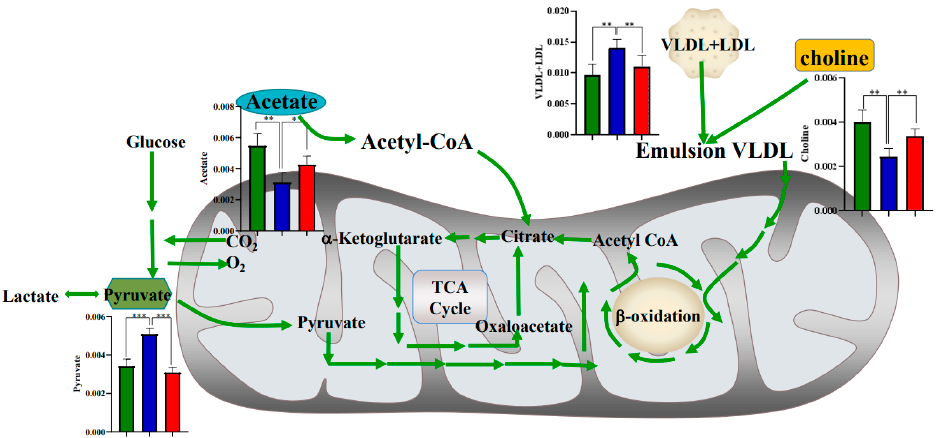
Figure 7. Metabolic regulatory network induced by SAP deficiency in ApoE − / − model. The histogram results of statistical analysis were from the data in 8 + 8 w. C57; ApoE − / − ; ApoE − / − ;SAP − / − . * p < 0.05, ** p < 0.01, *** p < 0.001.